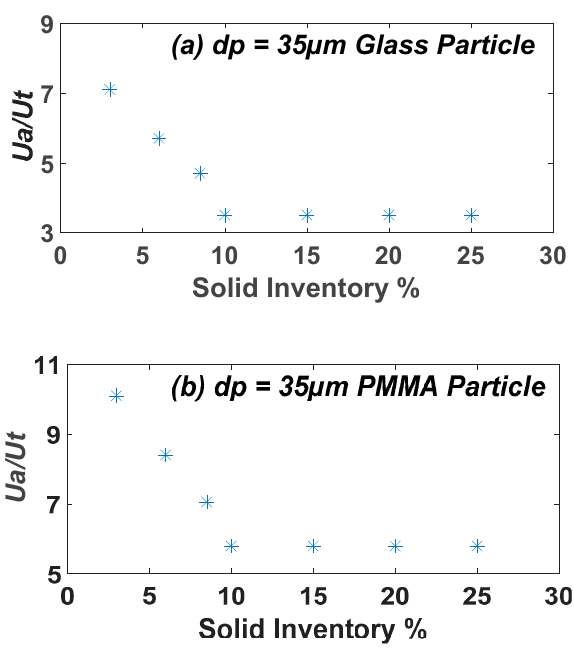
Figure 12. Solid inventory influence on transport transition velocity for 35 µ m ( a ) glass particles and ( b ) PMMA particles.